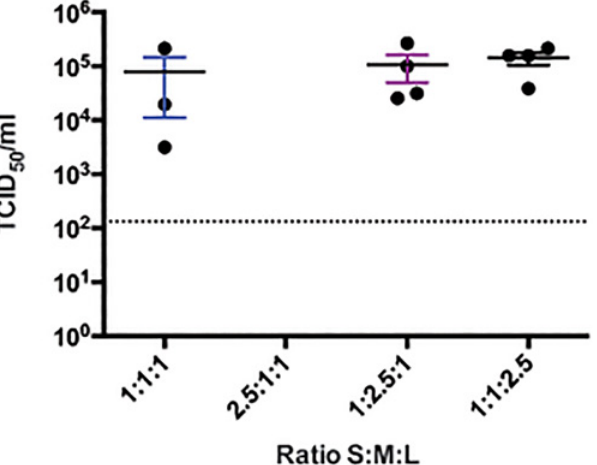
Fig 4. CCHFV rescue efficiency using varying ratios of plasmids producing complementary genome segments in BSR-T7/5. BSR-T7/5 cells were transfected with a total of 4.5 μ g of pT7-S, pT7-M, and pT7-L at the indicated S:M:L ratios, together with 0.66 μ g pC-N, 0.33 μ g pC-L opti, and 1 μ g pC-T7. Supernatants were collected 4 days after transfection, and viral titers were measured by TCID 50 determination. Dashed line indicates the limit of